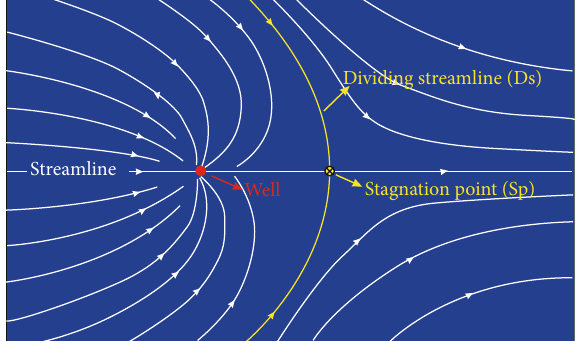
Figure 5: The schematic diagram of the fl ow system in the pumping phase.